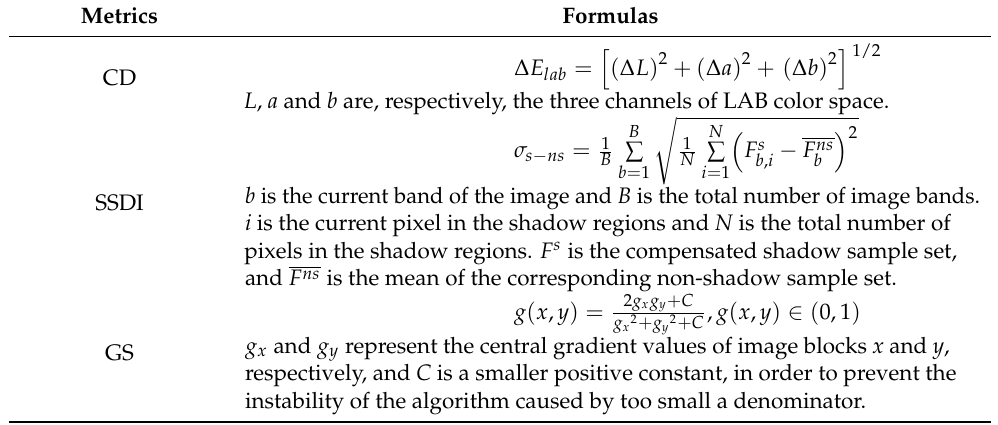
Table 1. Metrics of quantitative evaluation.